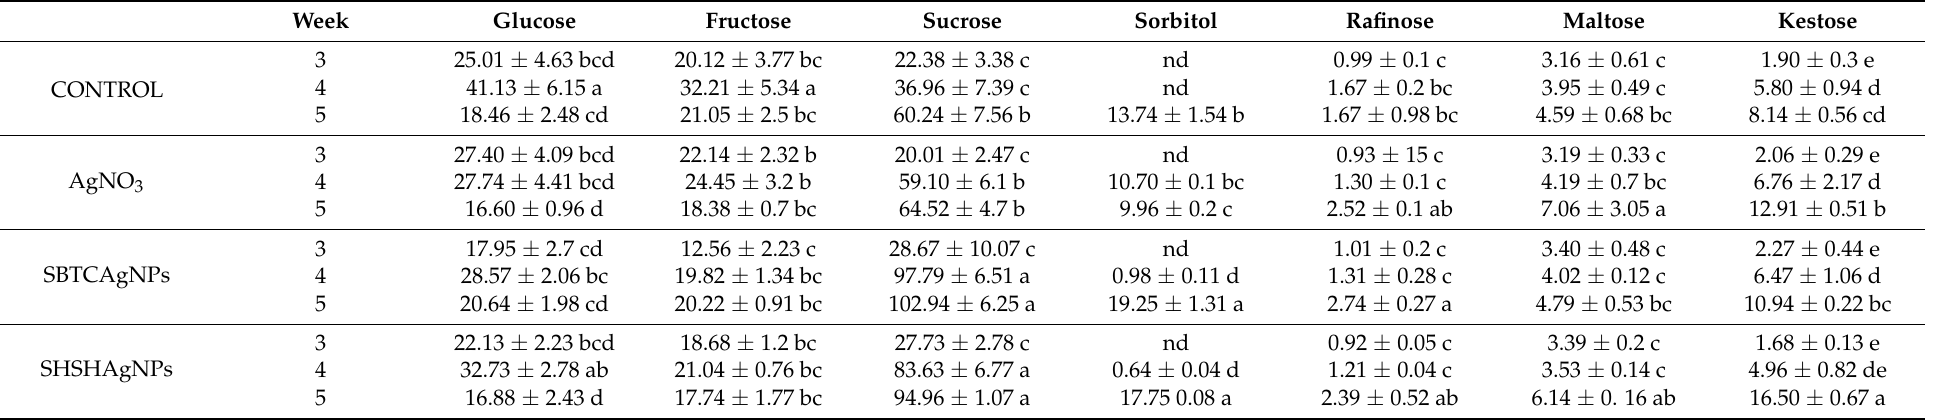
Table 2. The carbohydrate composition ( µ g/mg DW) in the leaves of the control and the AgNO 3 -, SBTCAgNPs- and SHSHAgNPs-treated wheat plants after 3, 4 and 5 weeks of growth. The presented data are the mean values based on 5 replicates ± SE. The mean values marked with the same letter within a parameter (sugar) did not differ significantly according to Duncan’s test, where p ≤ 0.05 (nd—not